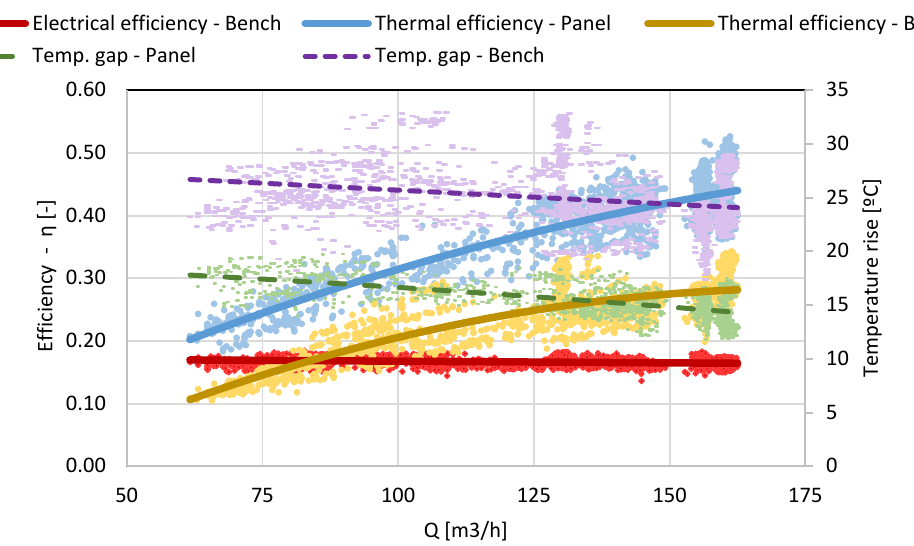
Figure 4. Variation of instant efficiency of individual panel, testing bench, and temperature rise versus air fluid flow inside the panel.